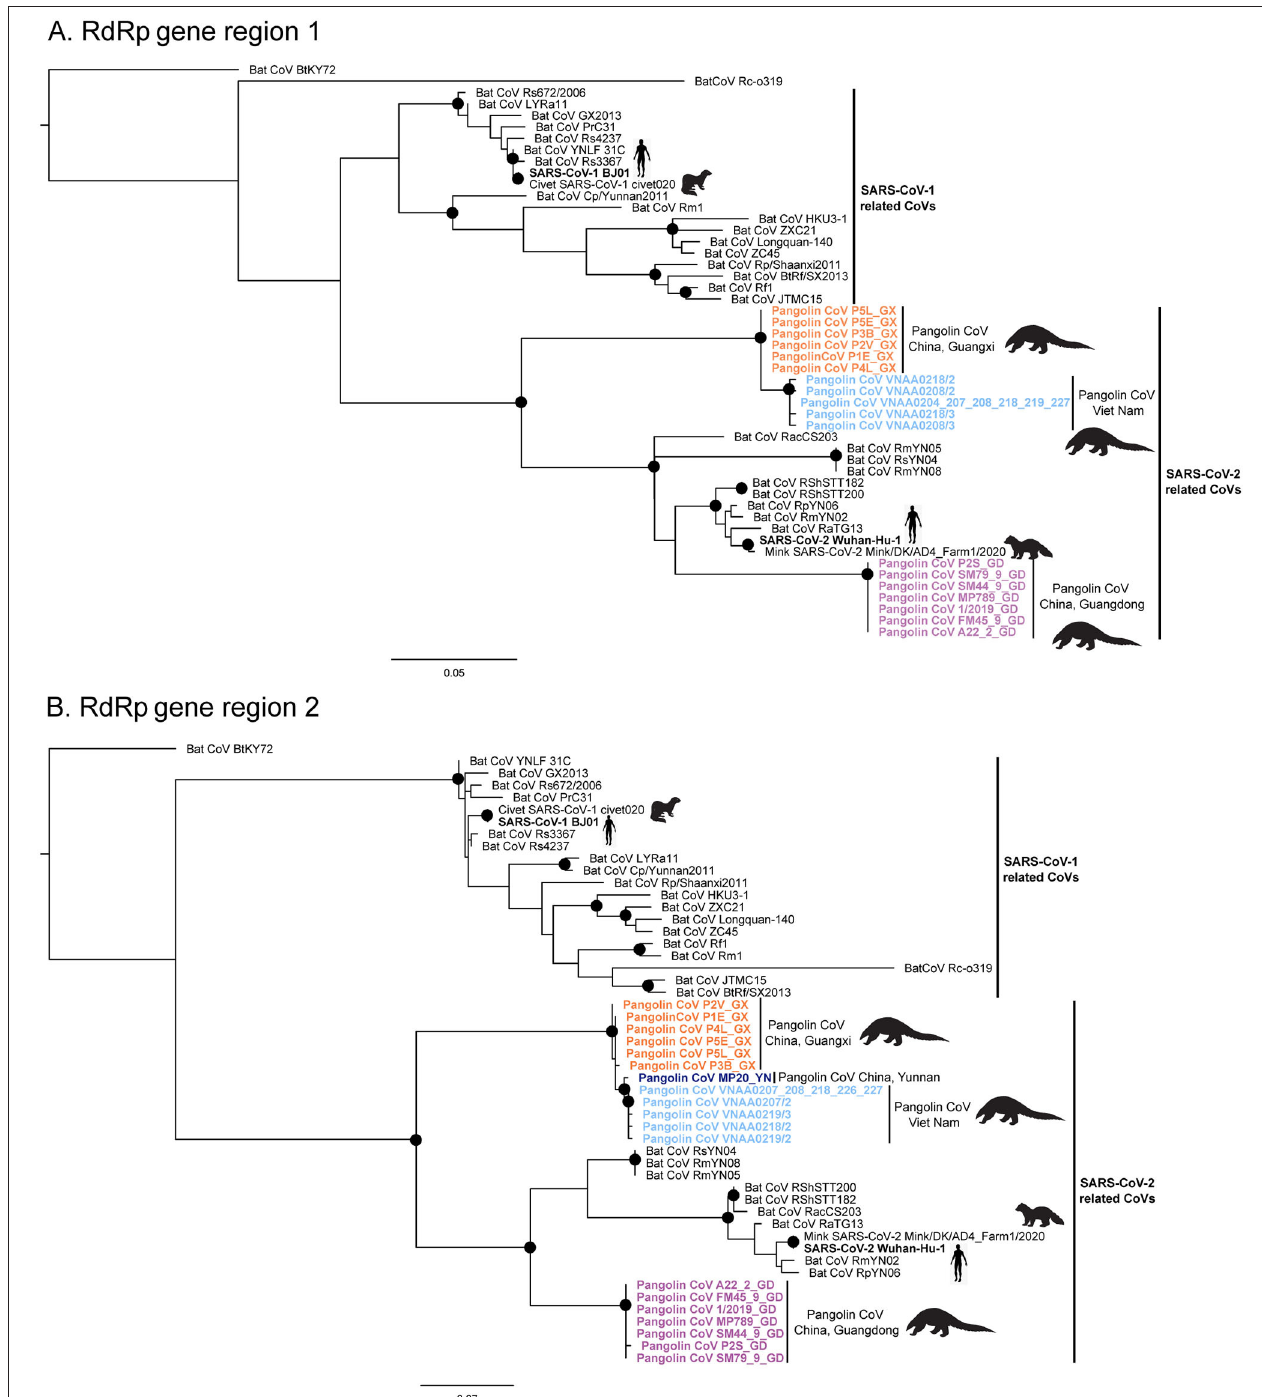
FIGURE 4 | Maximum Likelihood phylogenetic trees (HKY85 + G + I) depicting phylogenetic relationships among Sarbecoviruses inferred from conserved RdRp gene region 1, 455 bp (A) and conserved RdRp gene region 2, 439 bp (B) . Pangolin CoV sequences from the Sunda pangolins confiscated from the illegal trade in Viet Nam are highlighted in dark blue. Pangolin CoV sequences from the Sunda pangolins confiscated from the illegal wildlife trade in the Chinese provinces of Guangdong (GD), Guangxi (GX), and Yunnan (YN) are highlighted in purple, orange, and dark blue, respectively. Well-supported nodes (bootstrap support > 75%) are indicated with a black